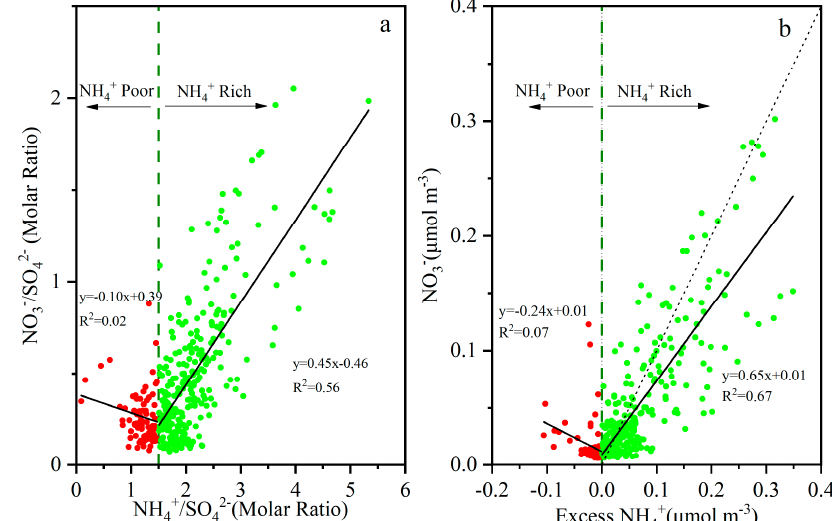
Figure 5. Molar ratios ( a ) of NO 3 − / SO 42 − vs. NH 4 + / SO 42 − and the correlations ( b ) of Excess- NH 4 + vs. NO 3 − under di ff erent condition (NH 4 + − rich or NH 4 + − poor).